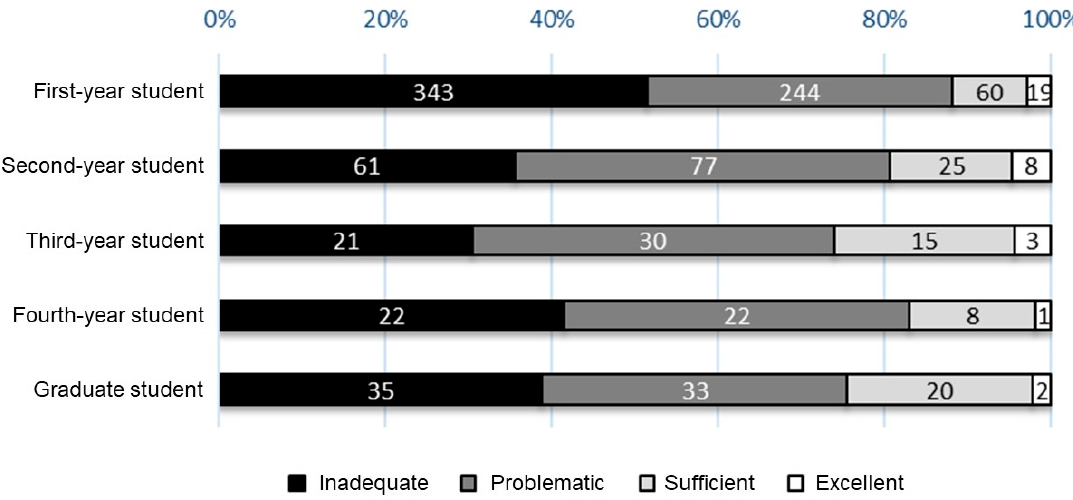
Figure 3. HL levels according to the year level of participating